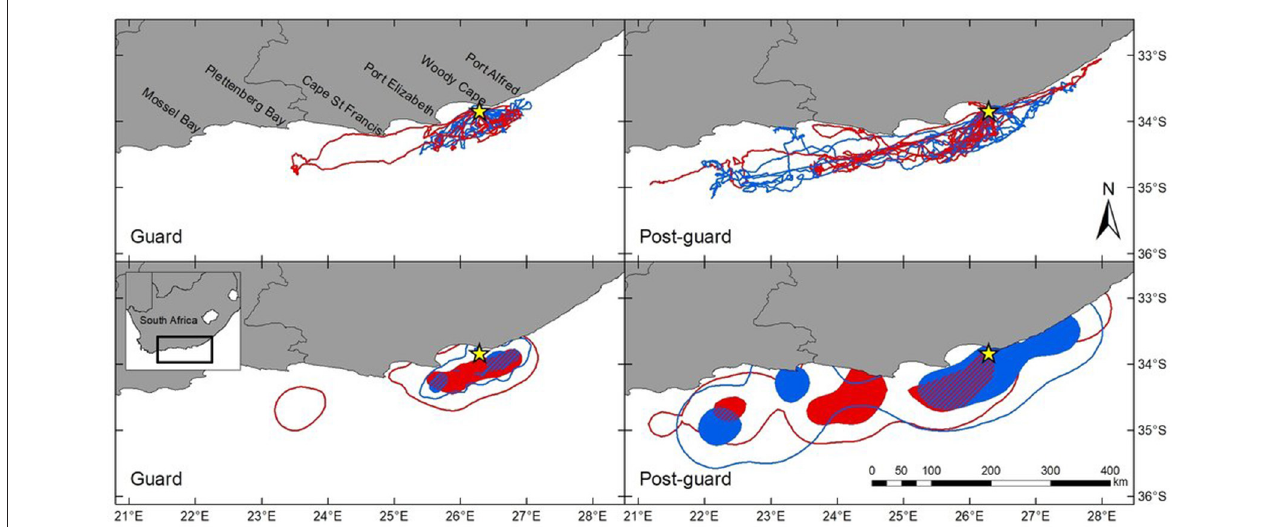
FIGURE 1 | Foraging ranges of female (red) and male (blue) Cape gannets during the guard and post-guard stages of the 2015/16 breeding season. GPS tracks represent all tracked individuals while kernel home range plots represent 9 randomly selected females and males for each breeding stage. Density contours are represented as 95% (unfilled areas) and 50% (filled areas). The overlap of the 50% contours of females and males are indicated by the red and blue striped area. Bird Island is indicated by the yellow star.